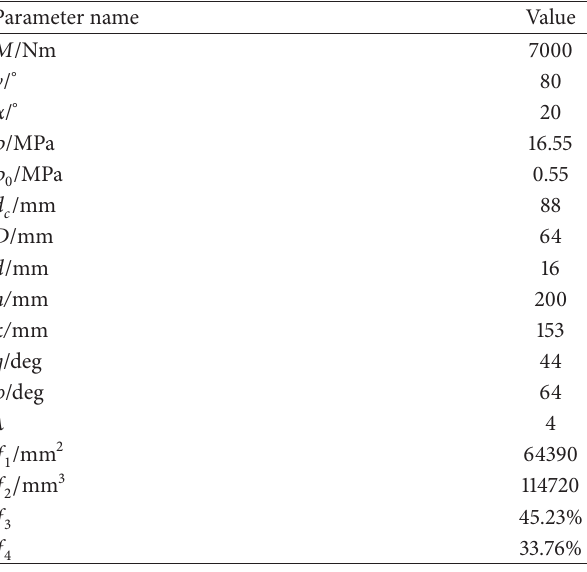
Table 1: Optimal design results.